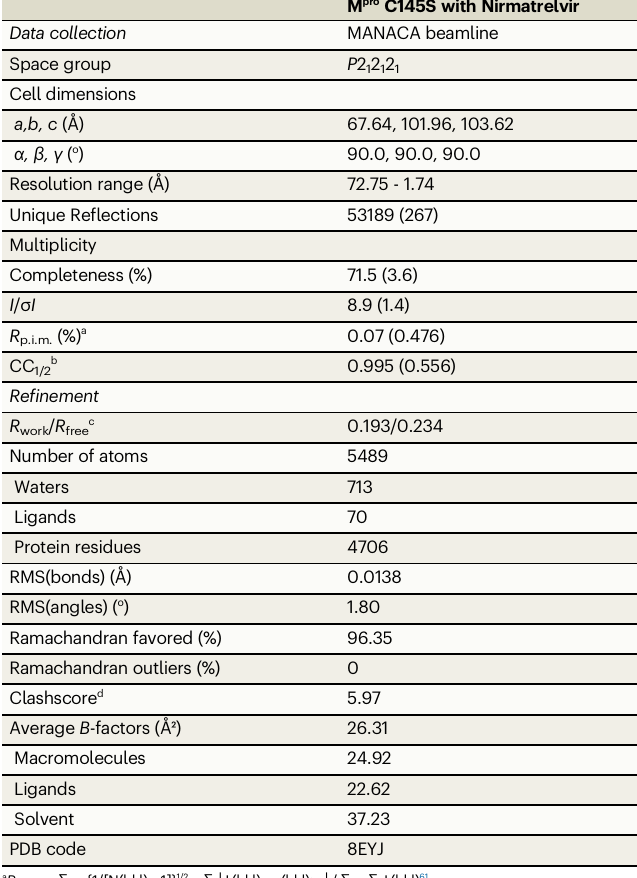
Table 2 | X-ray crystallography data collection, re fi nement and validation parameters and